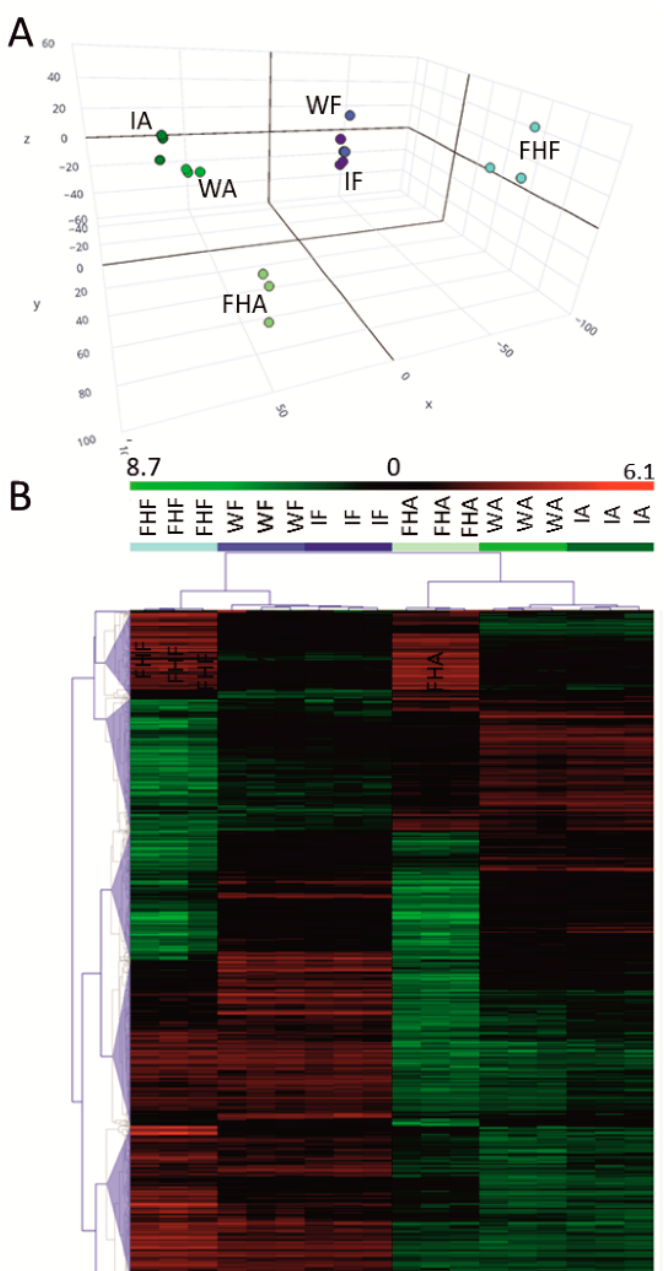
Figure 3. Principal component analysis (PCA) ( A ) and heatmap of the hierarchical cluster analysis (HCA) ( B ) of the expressed genes as determined by the RNA-Seq analysis. All the genes were considered in the PCA (A), whereas the HCA was based on those DEGs meeting a cut-off of STDEV > 0.6 and |Log 2 FoldChange| ≥ 1 for all the represented conditions: freshly harvested fruit flavedo (FHF); freshly harvested fruit albedo (FHA); wounded flavedo at 1 dpi (WF); wounded albedo at 1 dpi (WA); infected flavedo at 1 dpi (IF); infected albedo at 1 dpi (IA). The colors in the HCA for each condition are consistent with those in the PCA. Heatmap colors vary from light green (repression) to dark red (induction) on a Log 2 scale. Three biological replicates from each condition were used for the